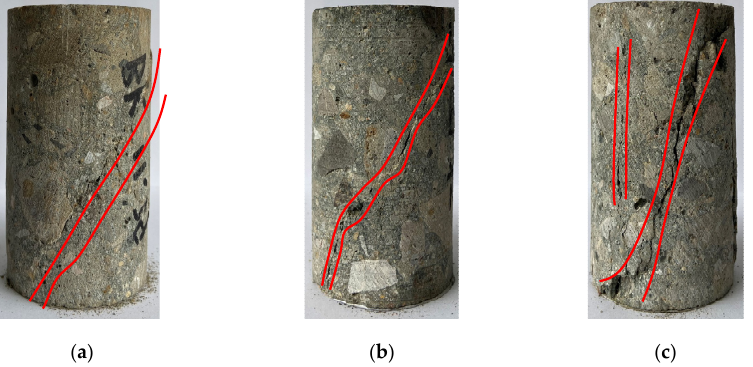
Figure 5. Failure modes of RAC under a confining pressure of 2.5 MPa. (a) RAC20, (b) RAC6012, (c) RAC8009